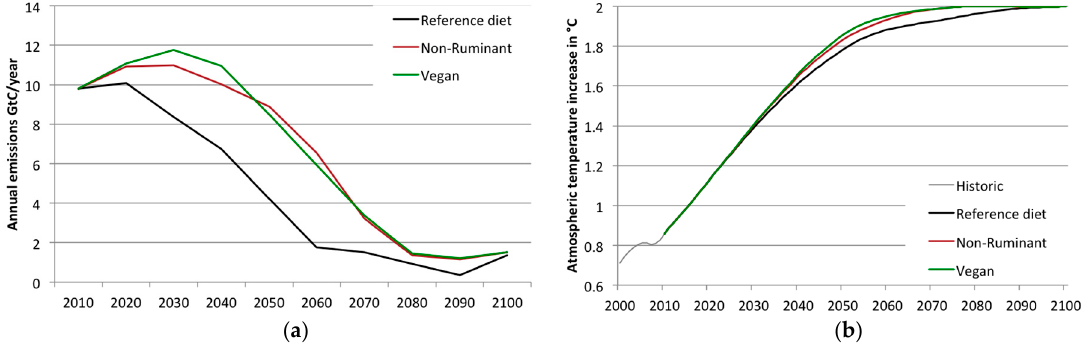
Figure 3. ( a ) Annual net CO 2 emissions for the different diets for a binding 2 °C target; and ( b ) temperature profiles for the different diets. CO 2 emissions (for the energy system) are higher for the non-ruminant and vegan diets, due to a substitution in mitigation between the energy system and the food system.